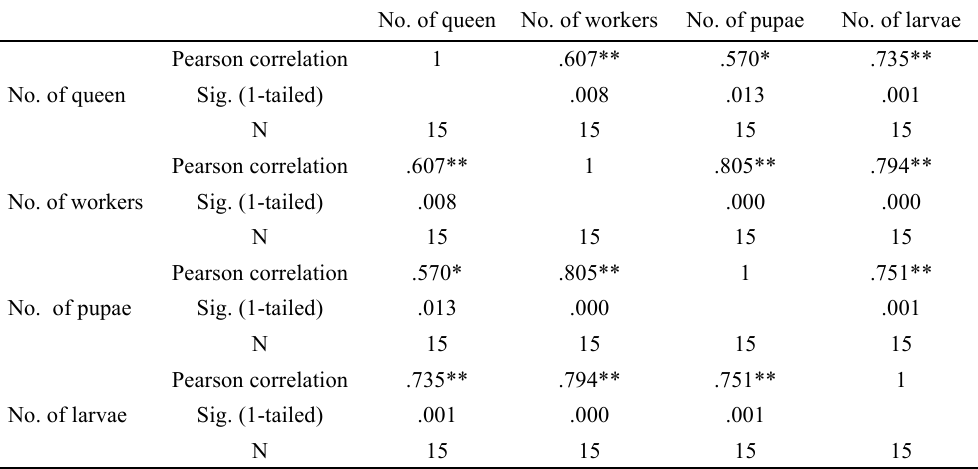
Table 5. Pearson correlation analysis (one-tailed) showing the correlation between the different castes. **p ≤ 0.01 and *p ≤ 0.05, n =